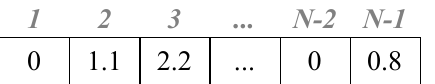
Figure 5. Codification for locating distributed generators in distribution networks.